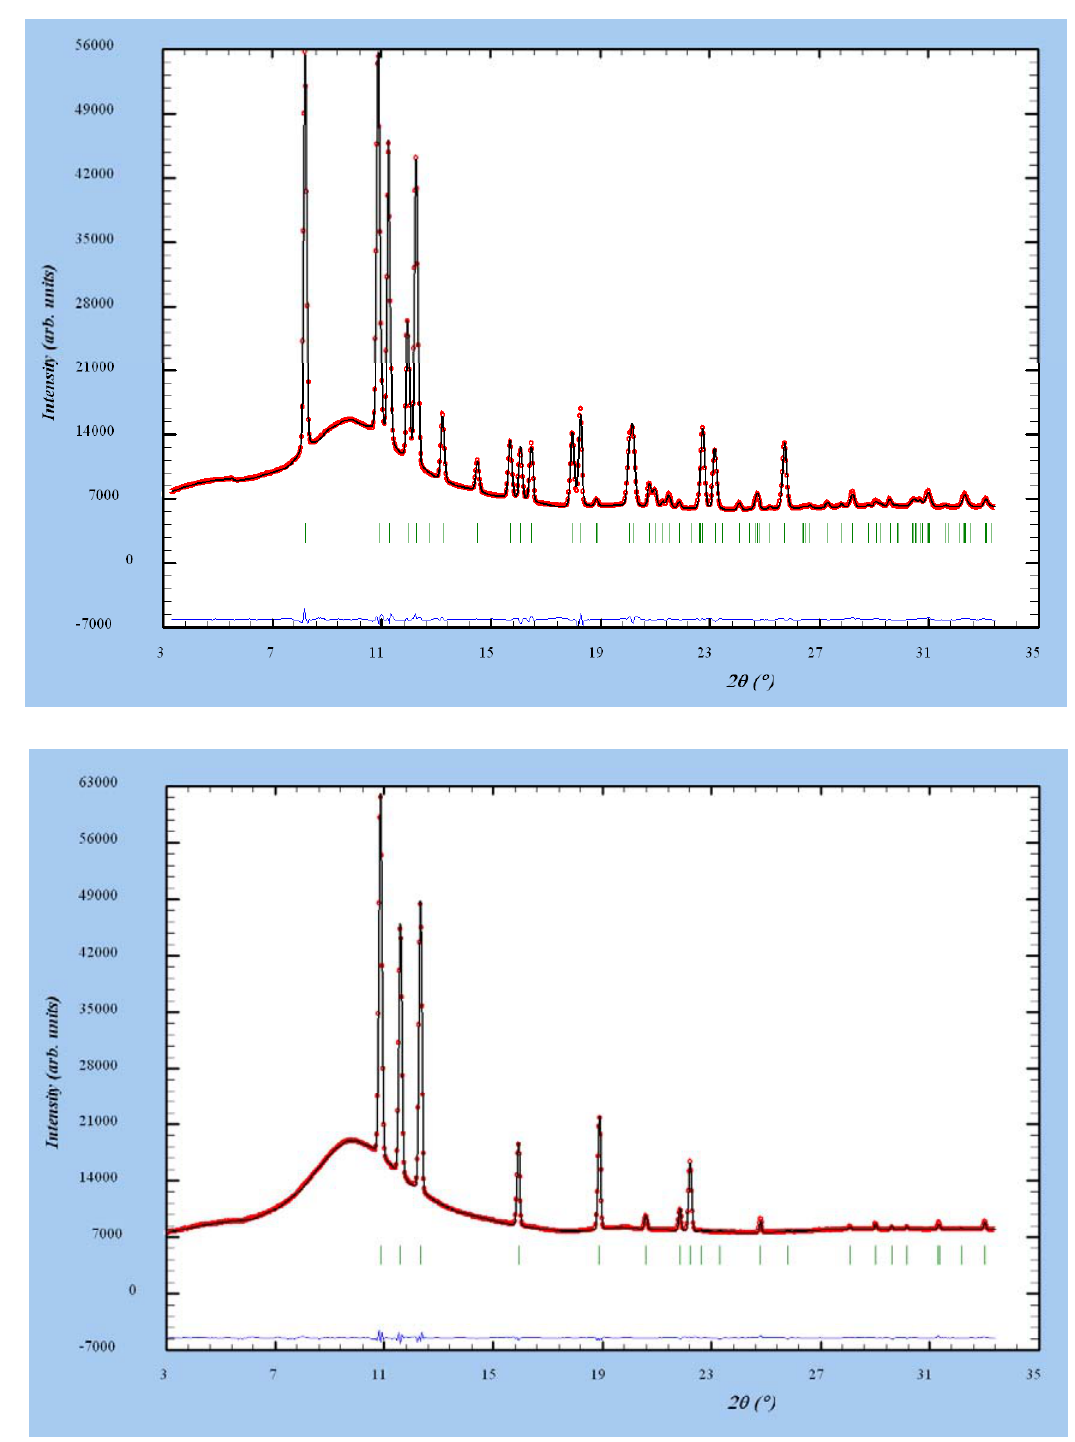
Figure 8. Rietveld refinement profile for the ball-milled LiBH (Top) and 388 K (Bottom),  = 0.700090